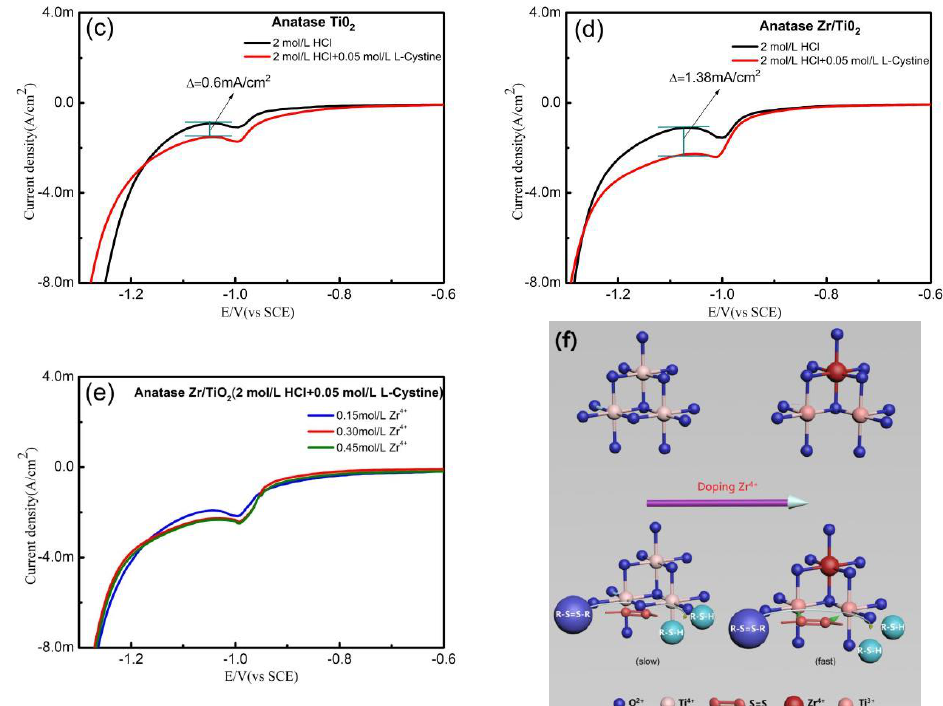
Figure 4. Linear sweep voltammetry (LSV) curves of different electrodes in 2 mol·L −1 HCl or 2 mol·L −1 HCl + 0.05 mol·L −1 L-cystine solutions (scan rate: 5 mV·s −1 ): ( a ) pure titanium, ( b ) amorphous TiO 2 nanoarray tube, ( c ) anatase TiO 2 nanoarray tube, and ( d ) anatase Zr/TiO 2 nanotube array electrode;